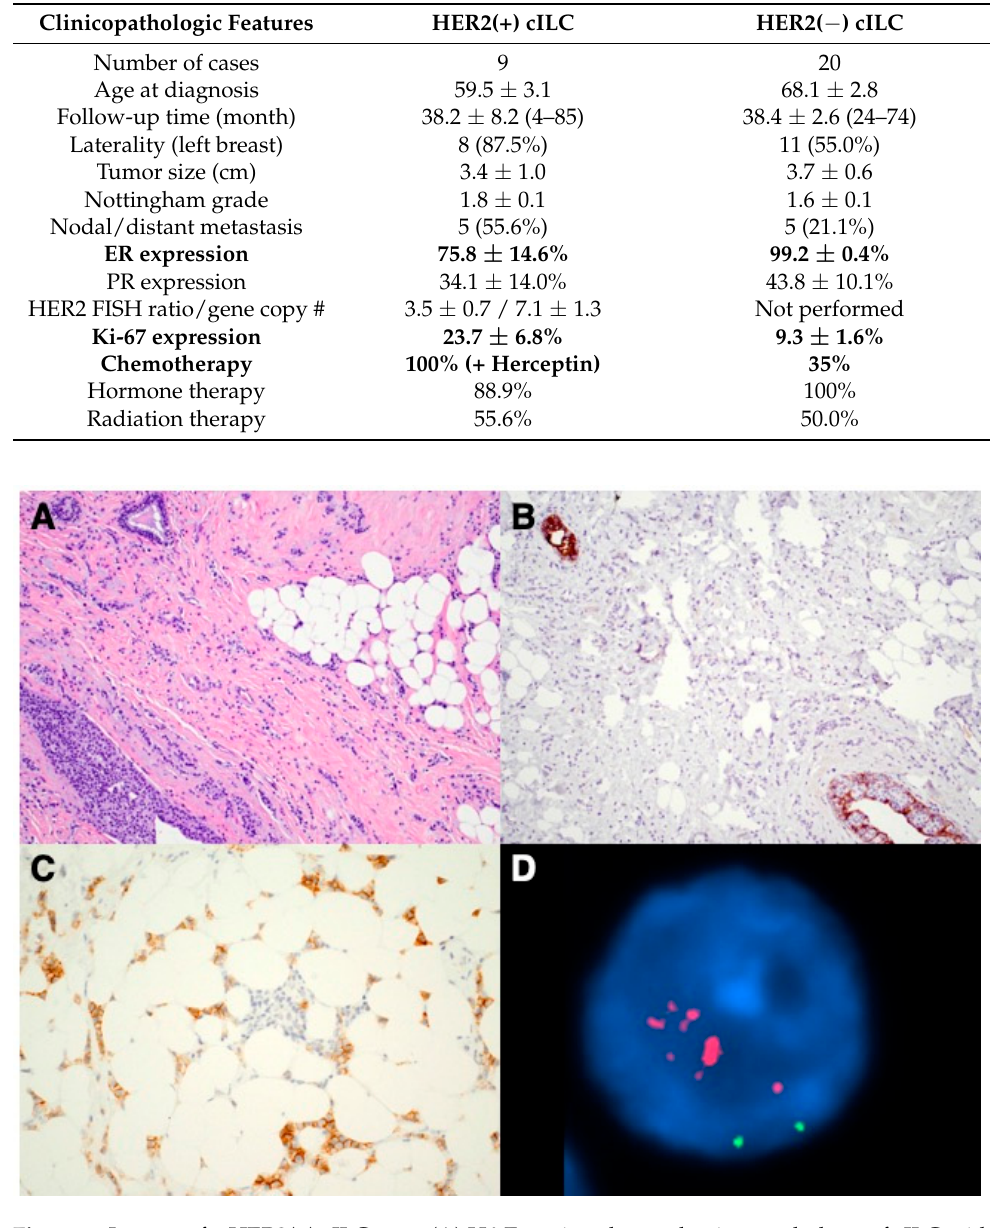
Figure 1. Images of a HER2(+) cILC case. ( A ) H&E section shows classic morphology of cILC with infiltrating small, uniform tumor cells present in single-file lines; ( B ) Immunostain confirms the complete loss of E-cadherin in the tumor cells (internal positive controls present); ( C ) HER2 IHC was interpreted as equivocal (2+); ( D ) Reflex FISH shows HER2 probe (in red fluorescence) was largely amplified (chromosome 17 centromere probe, in green